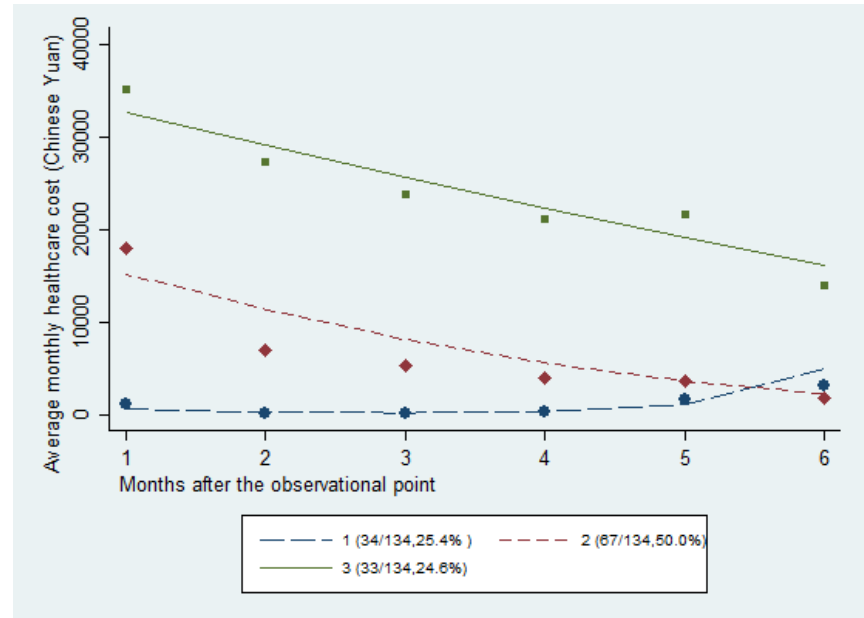
Figure 1. Results of the latent class analysis model.